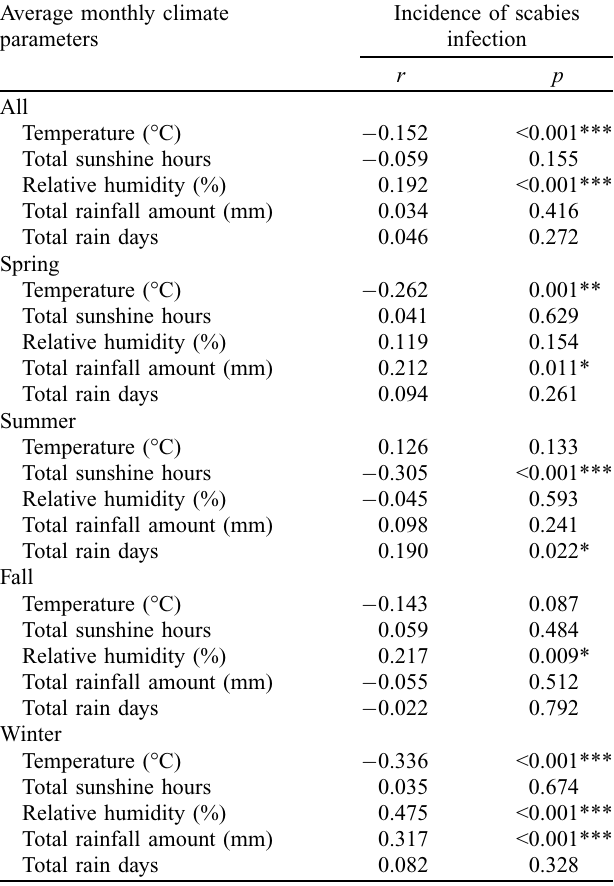
Table 3. Correlation of seasonal climate parameters to scabies from 2000 to 2013 in